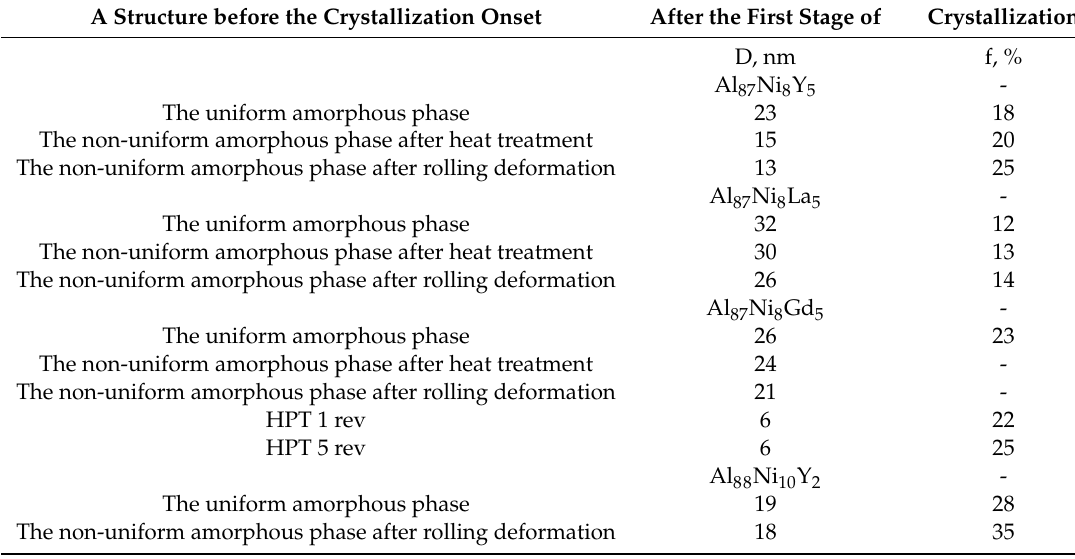
Table 1. The nanocrystal size (D) and the nanocrystalline phase fraction (f) formed in the uniform and non-uniform amorphous